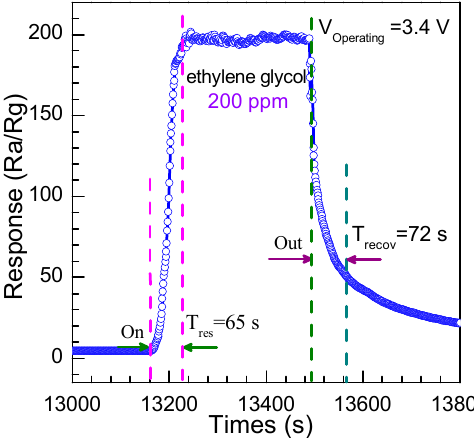
Figure 13. The response and recovery time of the gas sensor to 200 ppm ethylene glycol at the optimum operation